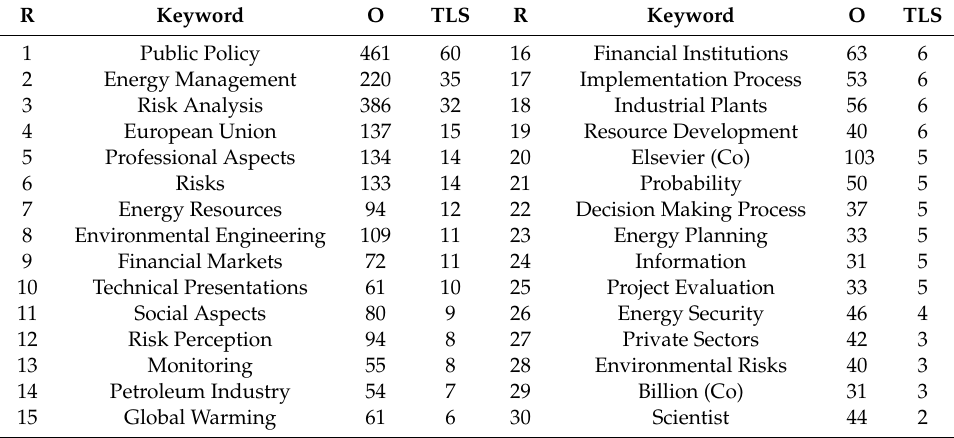
Table 10. Cluster 6. Top 30 keywords